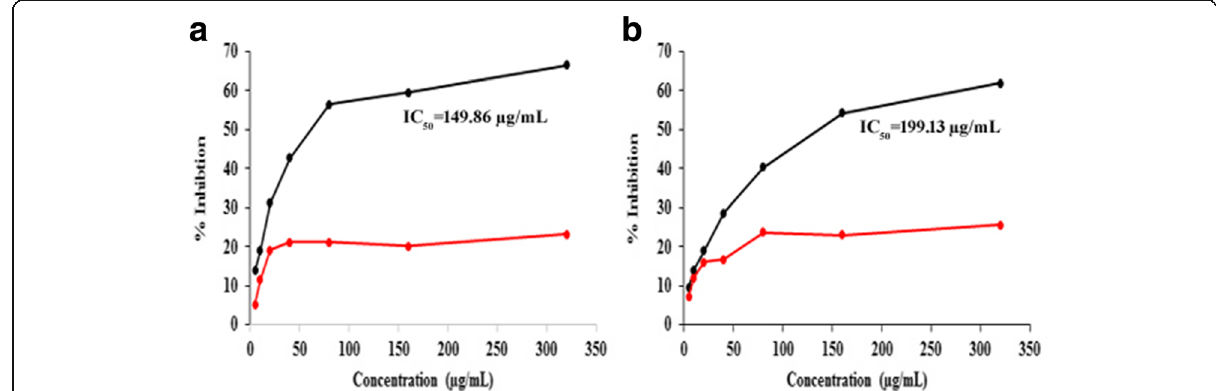
Fig. 9 a Inhibitory capacity of PHF1 (black) and PHF2 (red) when tested against NIH3T3 cell line. b Inhibitory capacity of PHF1 (black) and PHF2 (red) when tested against A375 cell line